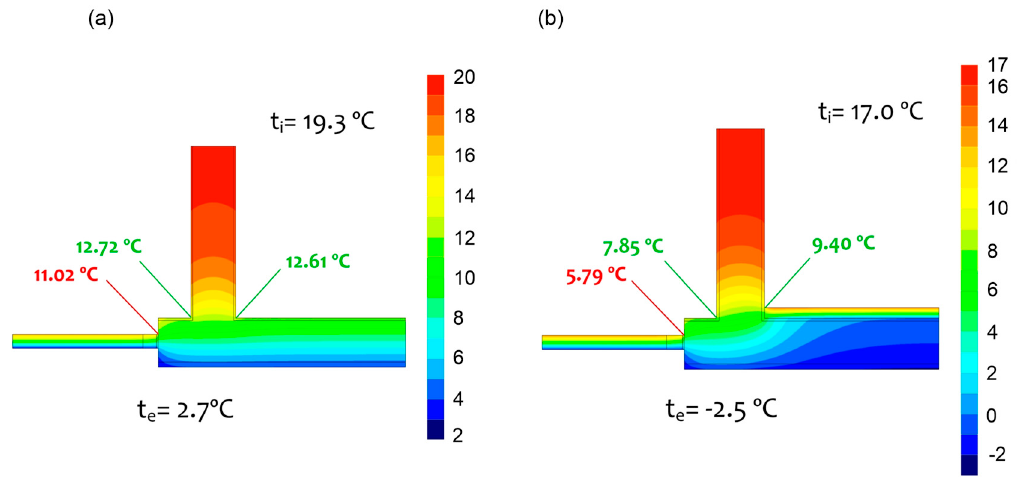
Figure 10. Simulated temperature distribution of the connection of outer and inner walls: ( a ) simulations without thermal insulation; ( b ) simulations with thermal insulation.